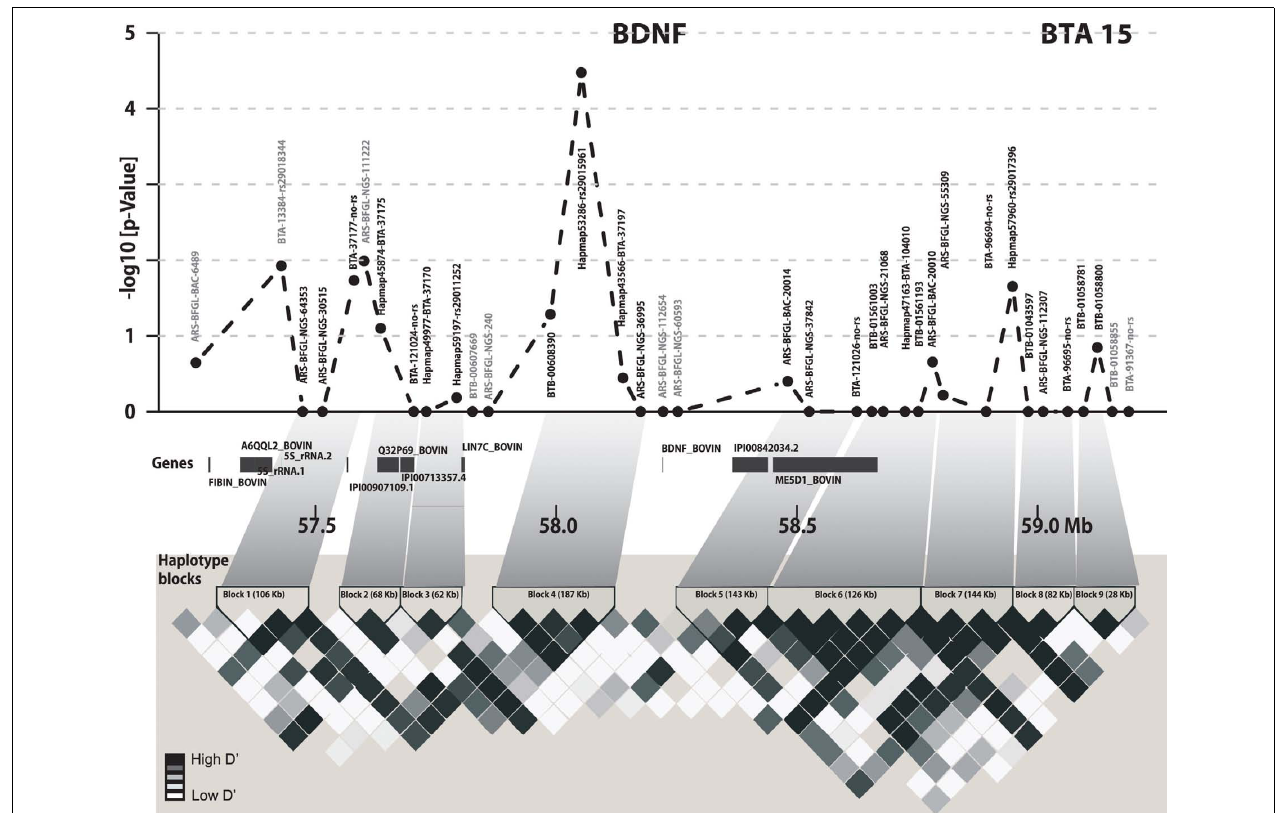
highlighted in dark gray.The lower part shows the pairwise D (cid:2) for the BDNF region using Haploview. Haplotype blocks are indicated with black